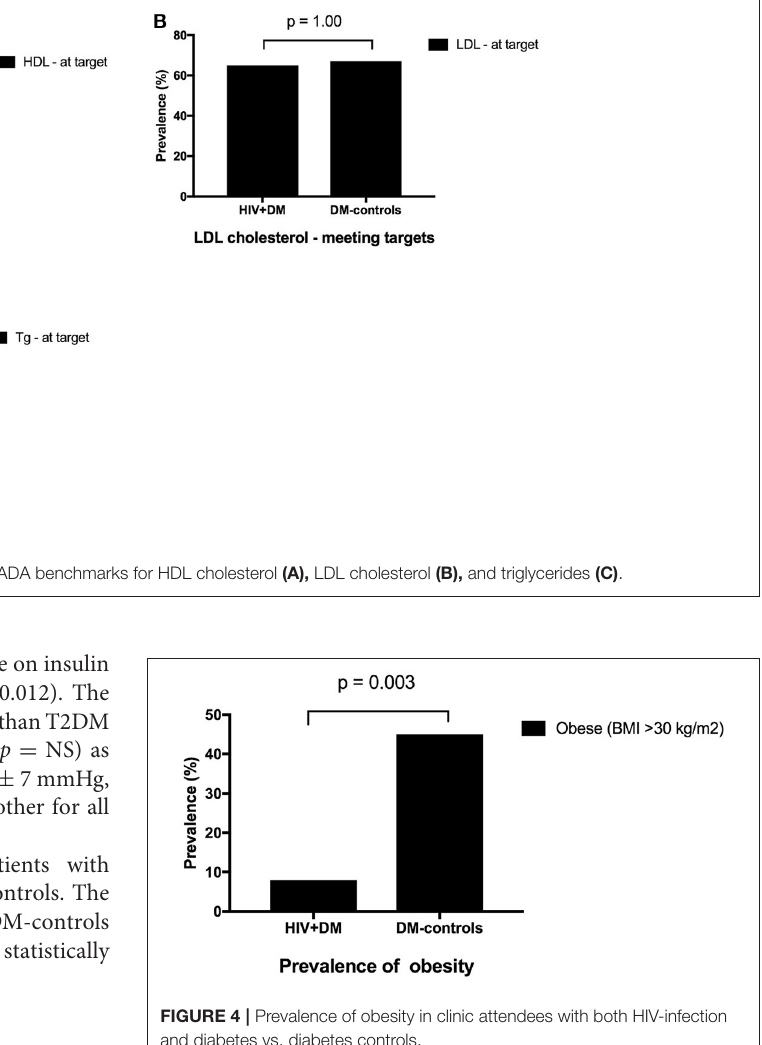
FIGURE 4 | Prevalence of obesity in clinic attendees with both HIV-infection and diabetes vs. diabetes